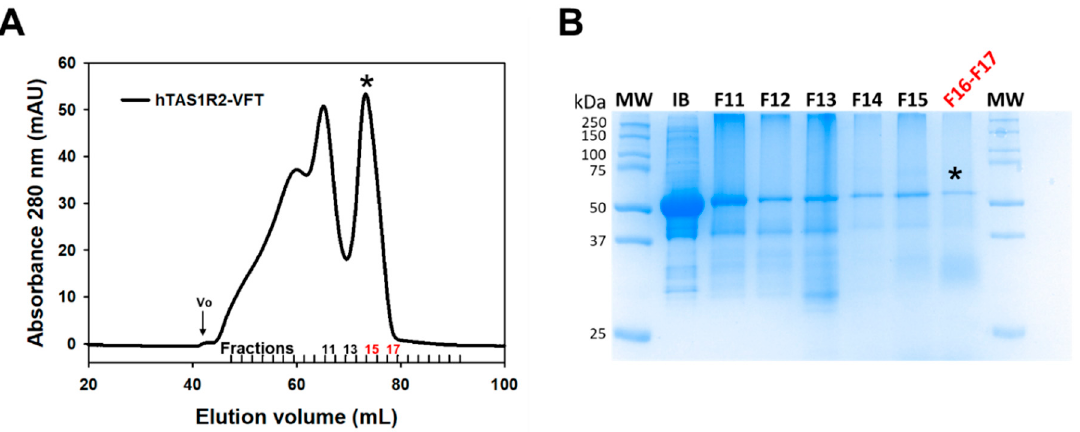
Figure 2. Size exclusion chromatography of purified hTAS1R2-VFT. ( A ) SEC analysis was performed on an Akta Pure FPLC system equipped with a Superdex 200 16/600 preparative grade column (GE Healthcare). Purified hTAS1R2-VFT was eluted using 50 mM Tris-HCl pH 8, 150 mM NaCl, 0.5 mM DDM, and 1 mM DTT at 1 mL/min. The last peak eluted at approximately 73.4 mL was analysed by ( B ) SDS–PAGE followed by staining with Coomassie blue. The fraction numbers refer to those designated in ( A ). Initial inclusion bodies (IB) used for refolding were loaded on SDS–PAGE as a control. Fractions F16 and F17, marked with a black asterisk, contained mainly hTAS1R2-VFT, used for subsequent measurements.